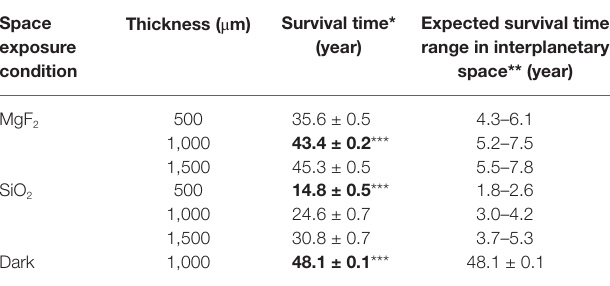
TABLE 1 | Survival time estimated from the survival time course of Deinococcus radiodurans R1.